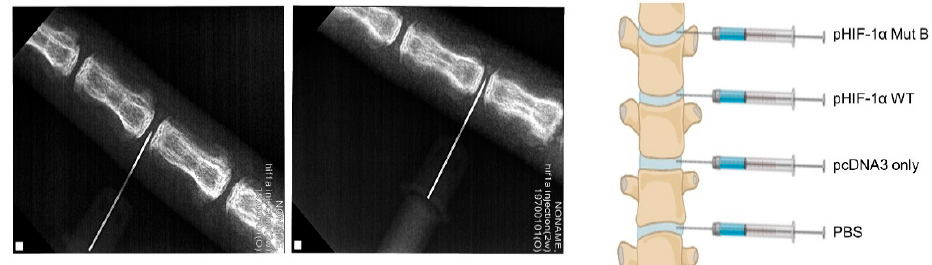
Figure 5. Schematic demonstrating the surgical model. ( Left ) Under X-ray, rat caudal IVDs were stabbed by a needle at a depth of 5 mm from the subcutaneous surface to the NP. ( Right ) Schematic illustration demonstrating transfection sites of rat caudal IVDs.